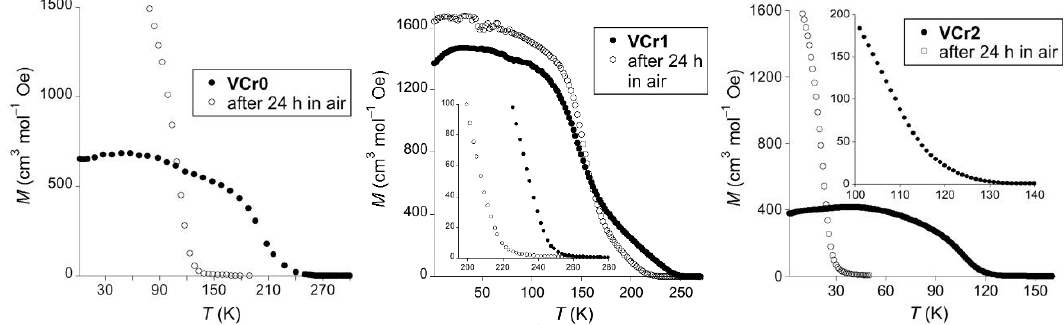
Figure 1. Field-cooled magnetization for VCr0 , VCr1 and VCr2 : as prepared (full circles) and after 24 h of air exposition (empty circles).